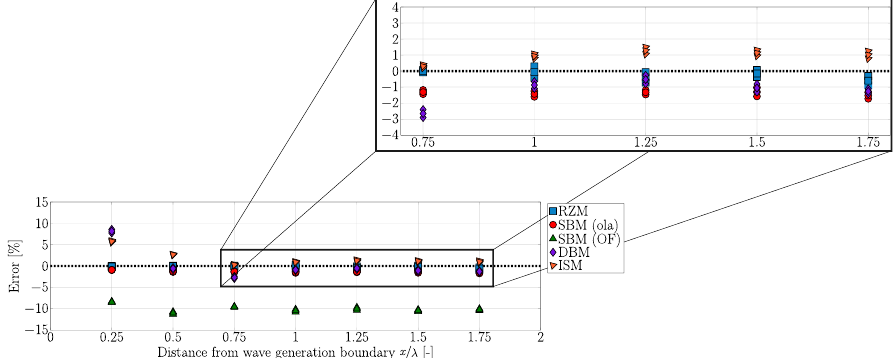
standard deviation σ ¯ (cid:101) for the five ¯ H ± standard deviation for the five ±